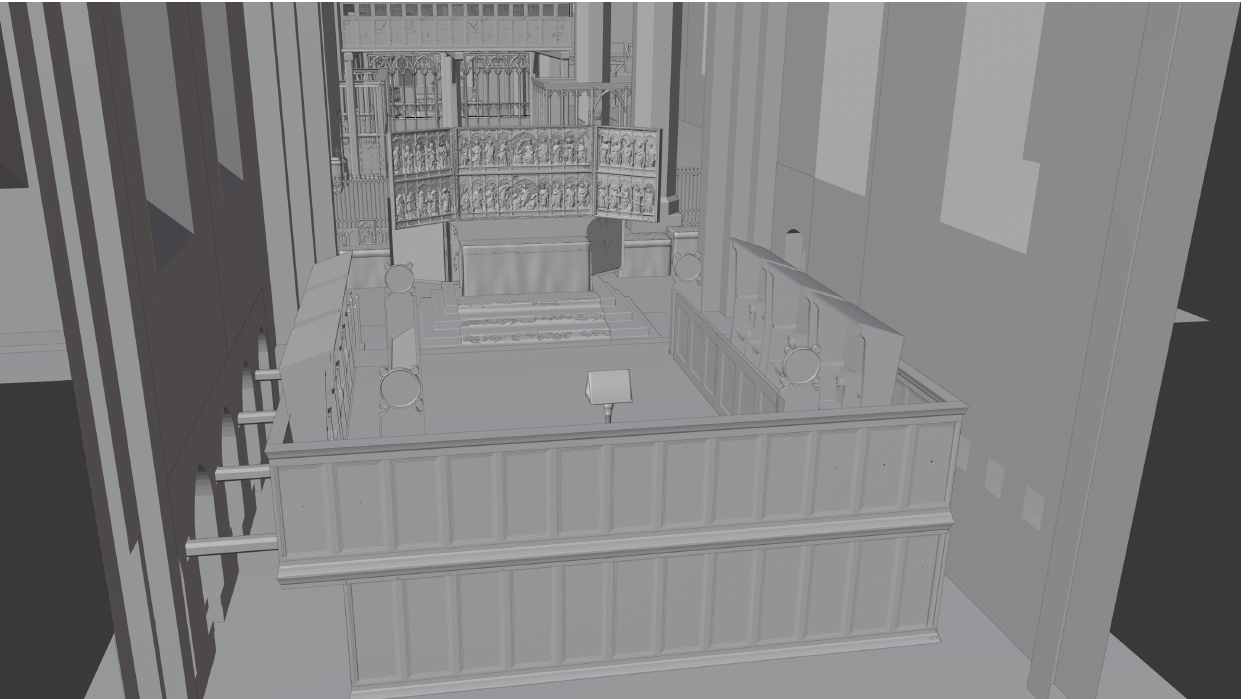
Figure 5. 3D model of the monks’ choir with beams fitted in the wall niches to the left, supporting the platform. The back part of the stalls are modeled based on preserved stalls used by the monks. View from the west towards the east. The main altar is visible east of the